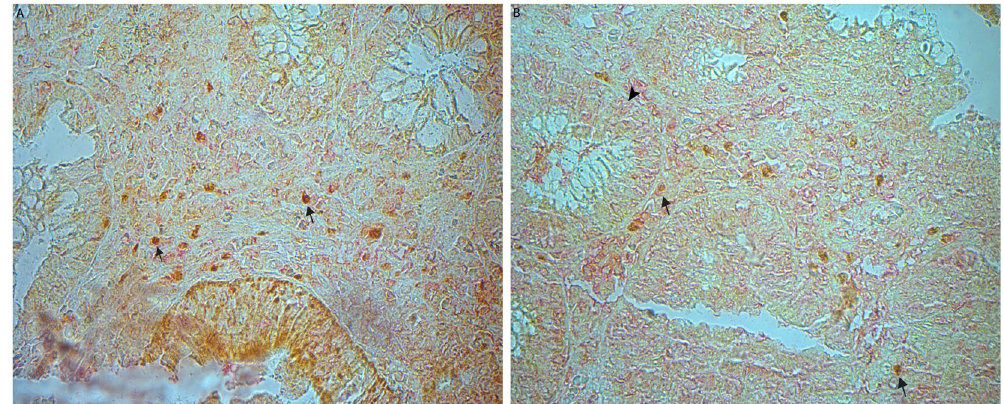
Figure 6. Photographic representations of ST2 expressed in FoxP3-positive Tregs in the adenoma stroma. Double immunohistochemistry images revealed that many FoxP3-labelled ( red color in A ) Tregs expressed ST2-IR ( brown color in B ) in a represent adenoma section. ( A,B , double immunohistochemistry images, original magnification 400 × ; counterstaining was